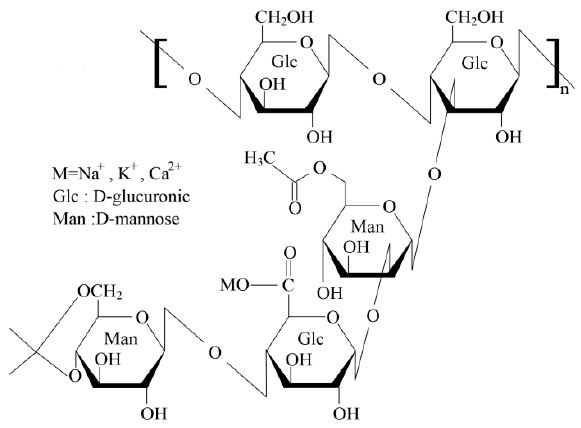
Figure 8. Molecular structures of xanthan gum (XG).